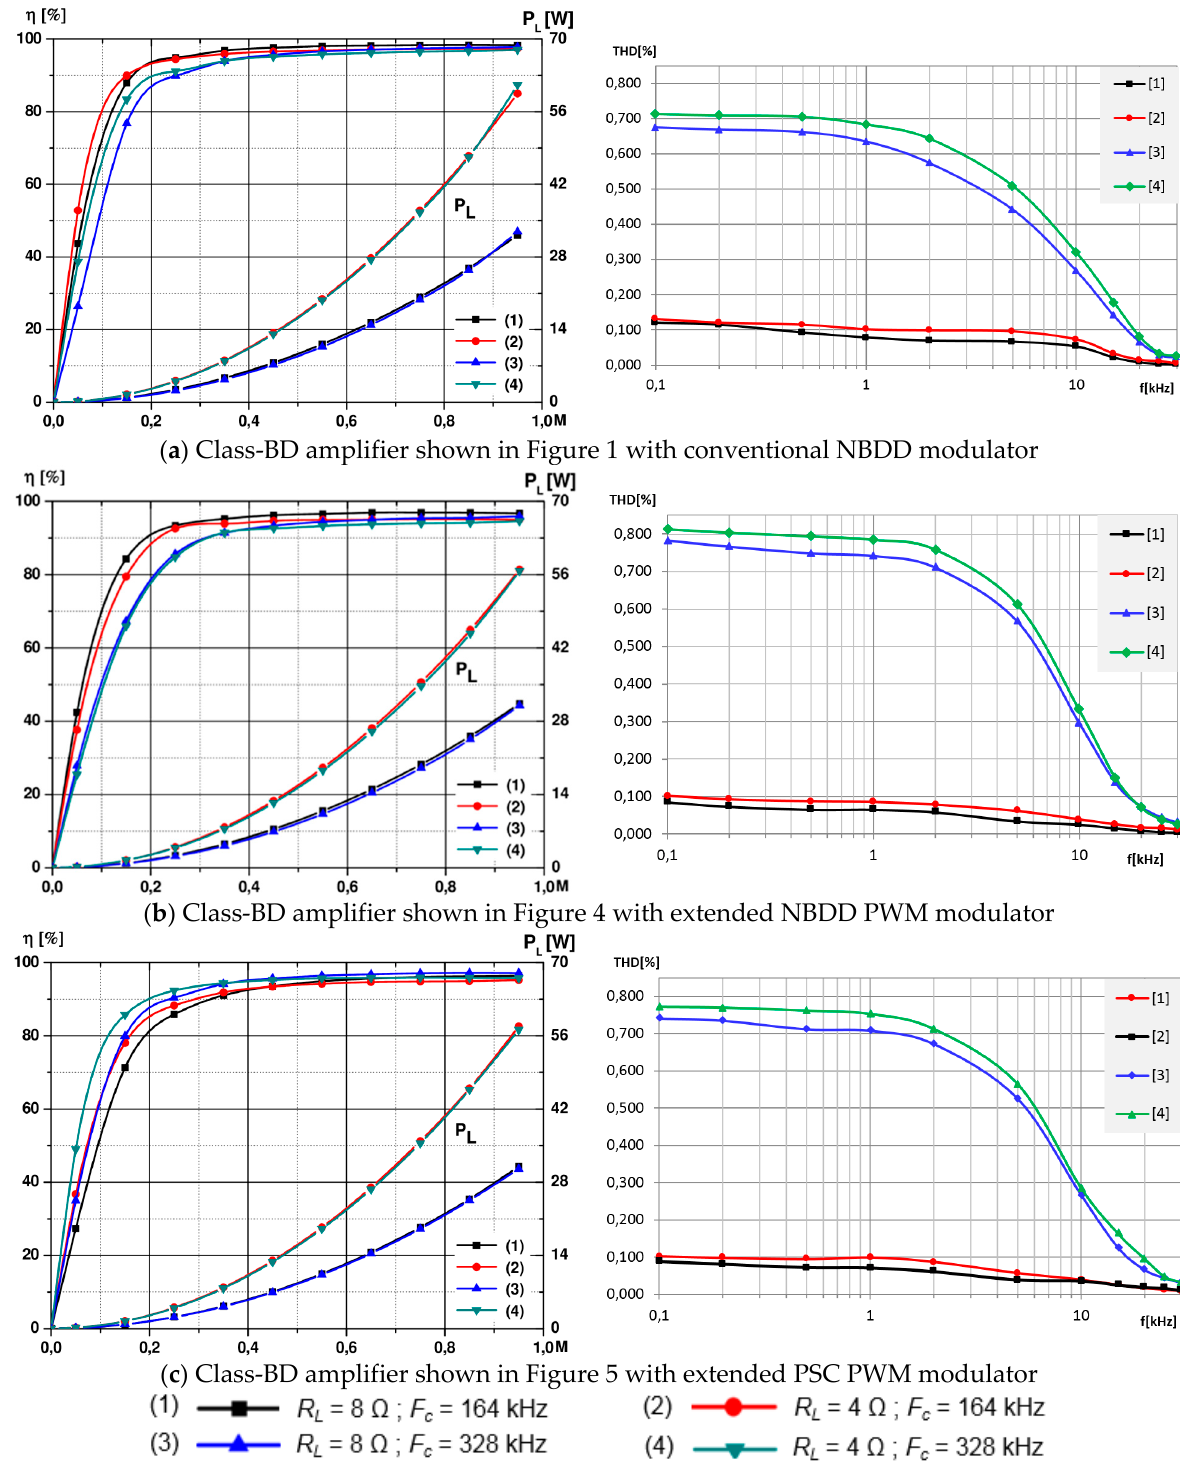
Figure 7. Efficiency and output power vs. modulation index M , as well as THD as a function of the audio signal frequency for three amplifiers shown ( a ) in Figure 1, ( b ) in Figure 4, and ( c ) in Figure 5, respectively.